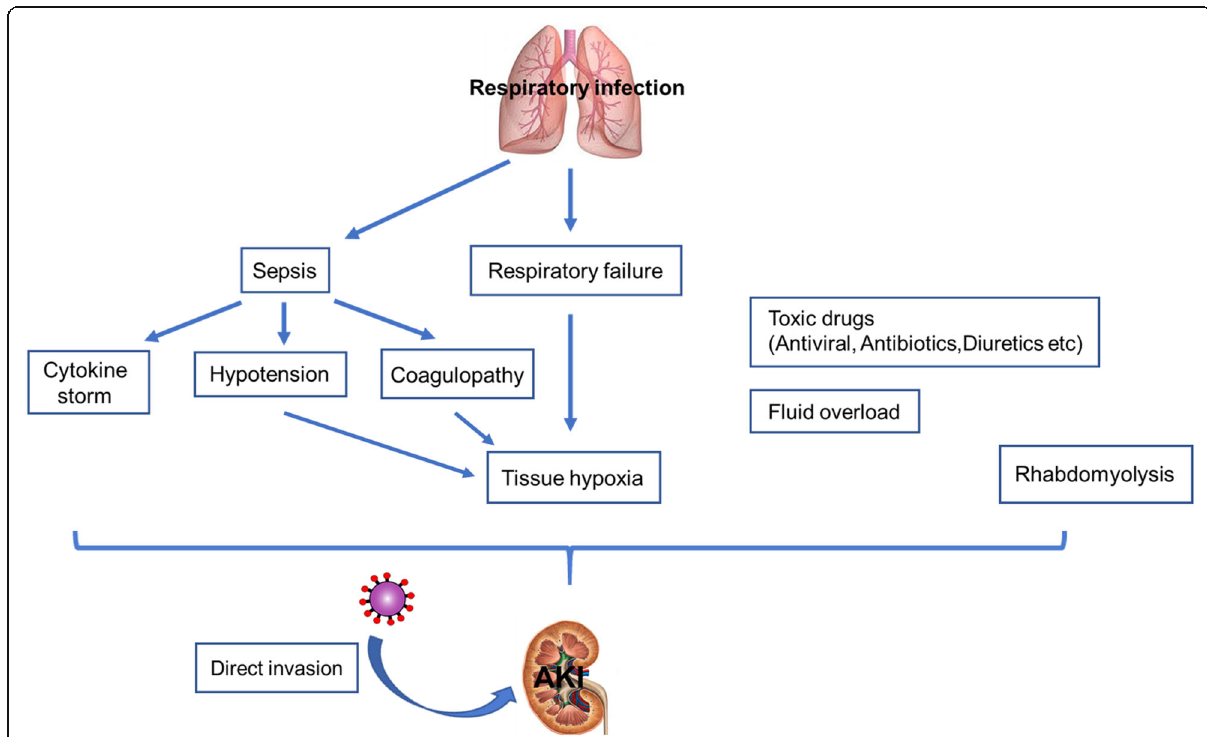
Fig. 2 Possible AKI mechanisms in COVID-19. Etiologies of AKI are not fully understood. The causes appear to be multifactorial and wide-ranging, including direct viral invasion of kidney tissue, cytokine storm, hypotension, hypercoagulation, tissue hypoxia, toxic drugs,